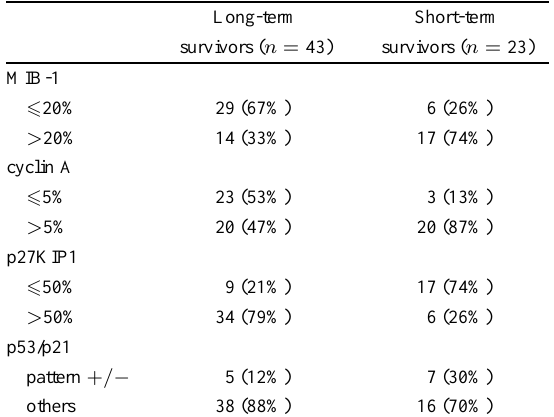
Immunohistochemical characteristics of primary breast carcinomas from the selected patient groups of long-term survivors ( n = 43) and short-term survivors ( n =